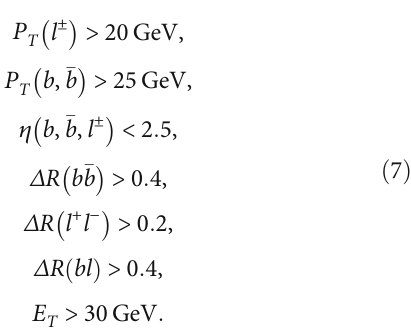
Figure 6: d vs. Λ for observable C g 3ab − 1